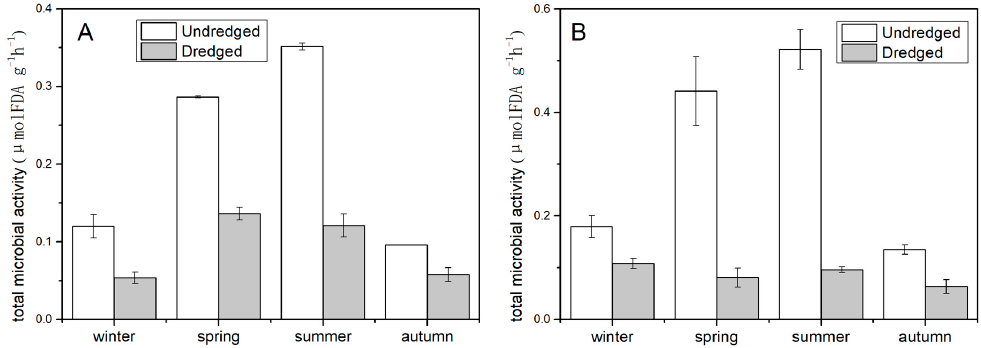
Figure 5. Total microbial activity in undredgedand dredged sediments of the Inner Bay ( A ) and Outer Bay ( B ) in January, April, July, and October 2013, Error bars represent ±1 SE of triplicate samples.